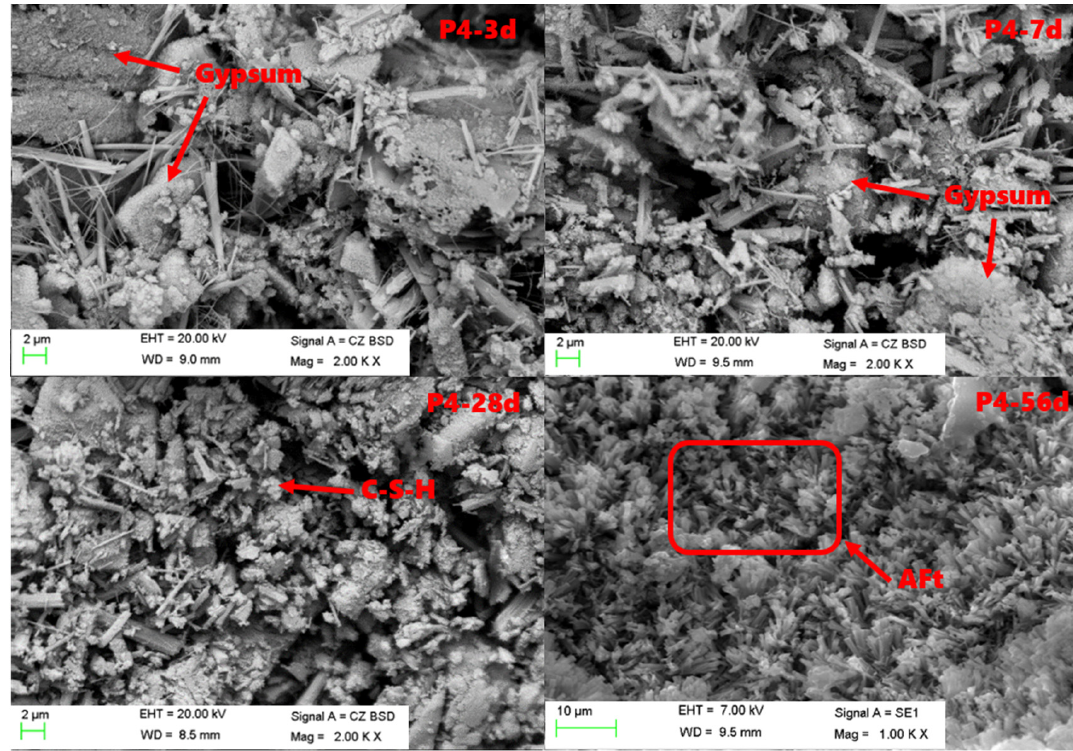
Figure 5. SEM images of hydration products of No.2 at various ages.